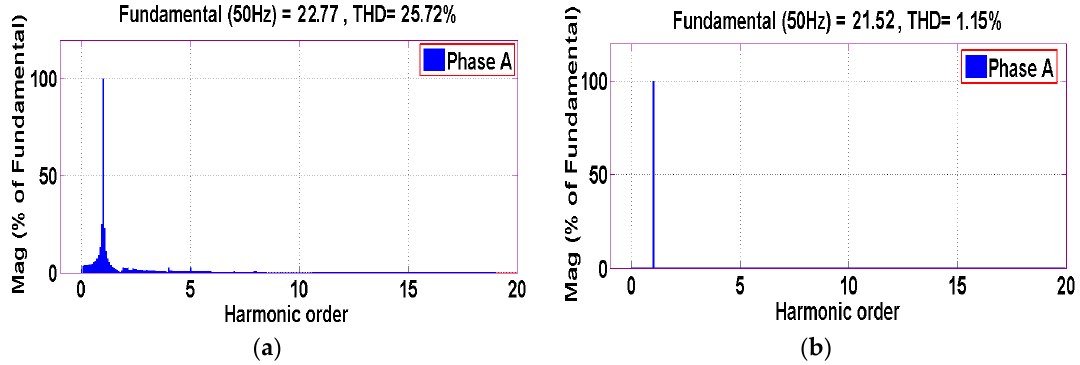
Figure 10. Simulation results under steady state voltage and current: (a) total harmonic distortion (THD) of load current prior to compensation; (b) after compensation THD of source current.